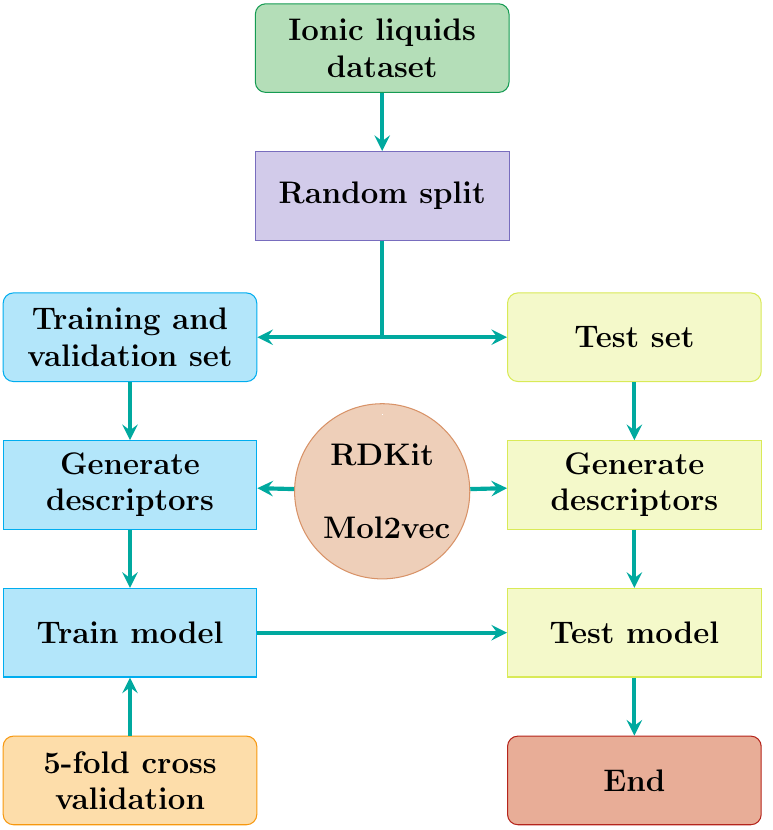
Figure 1. Workflow showing how the data were split, features generated, and cross validation used in modeling toxicity prediction for ionic